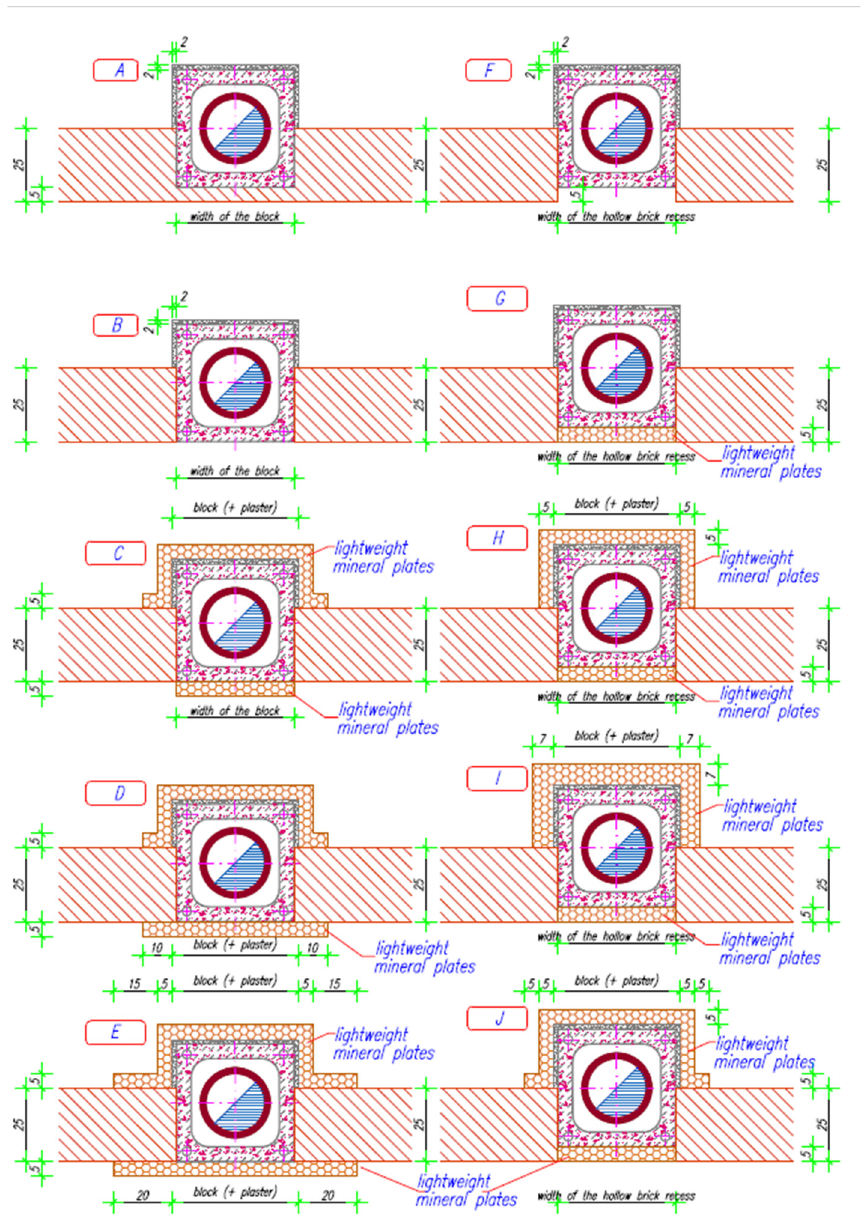
Figure 9. Design models of chimney structures adopted for simulation analyses without insulation ( A , B , F ) and with insulation ( C – E , G – J